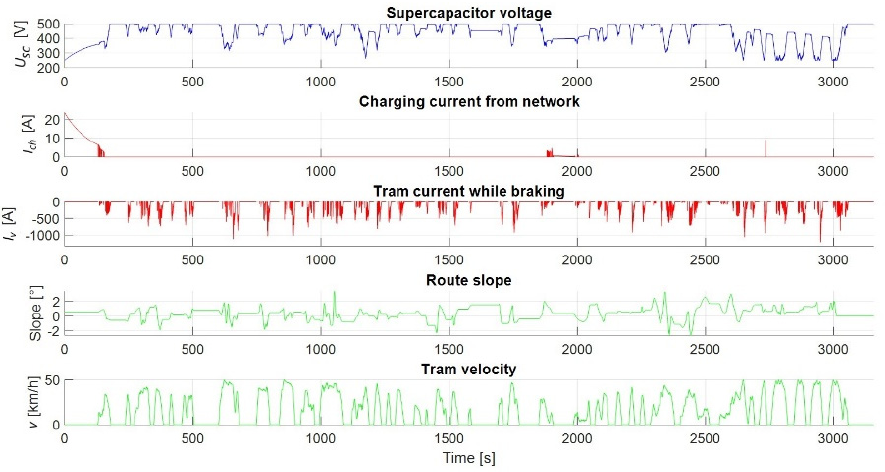
Figure 18. Waveforms during supercapacitor charging while using the minimum energy algorithm.